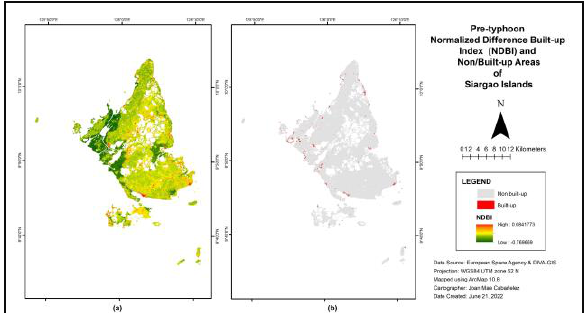
Figure 13 . NDBI and built-up layers of Siargao Islands during pre-typhoon condition.